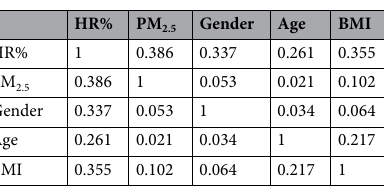
Table 4. Correlation of explanatory variables. **The correlation was significant at the 0.01 level